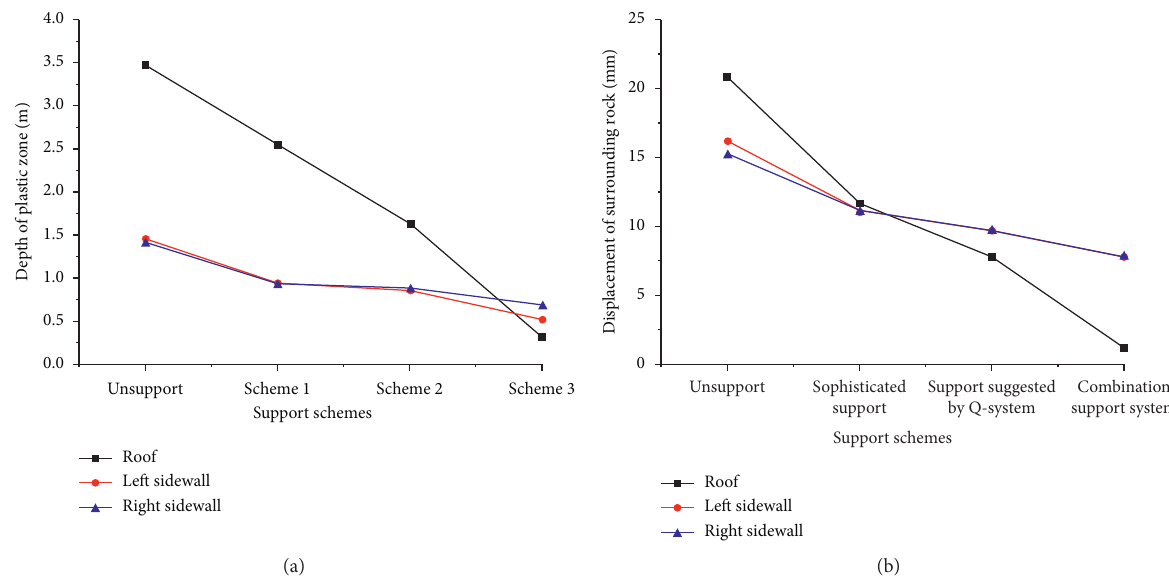
Figure 12: The depth of plastic zone and total displacement surrounding the drift for 3 different support